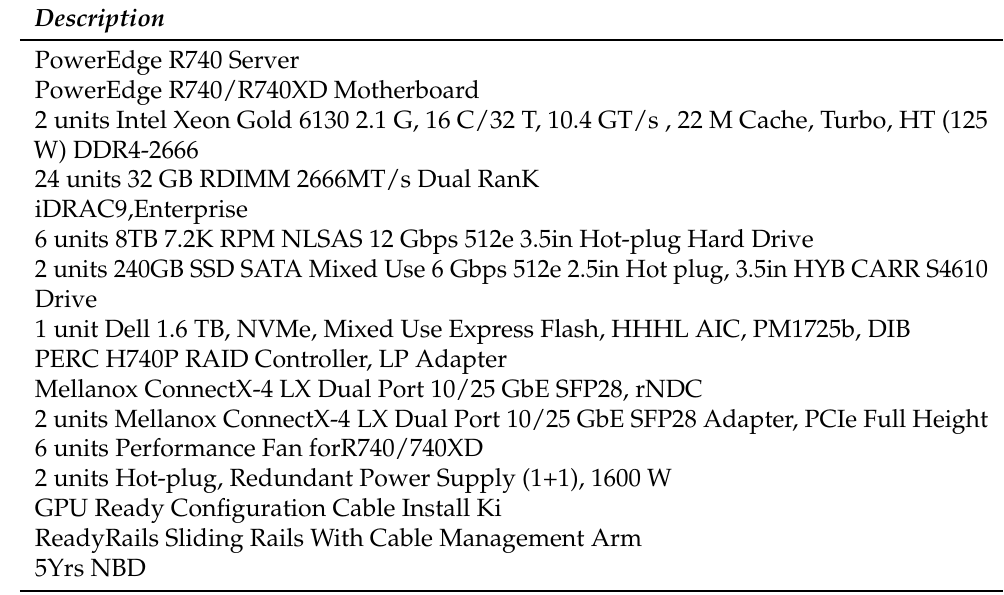
Table 3. Hyper-Converged Compute BoM.